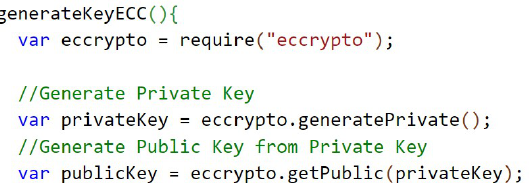
Figure A11. Generate ECC keys.